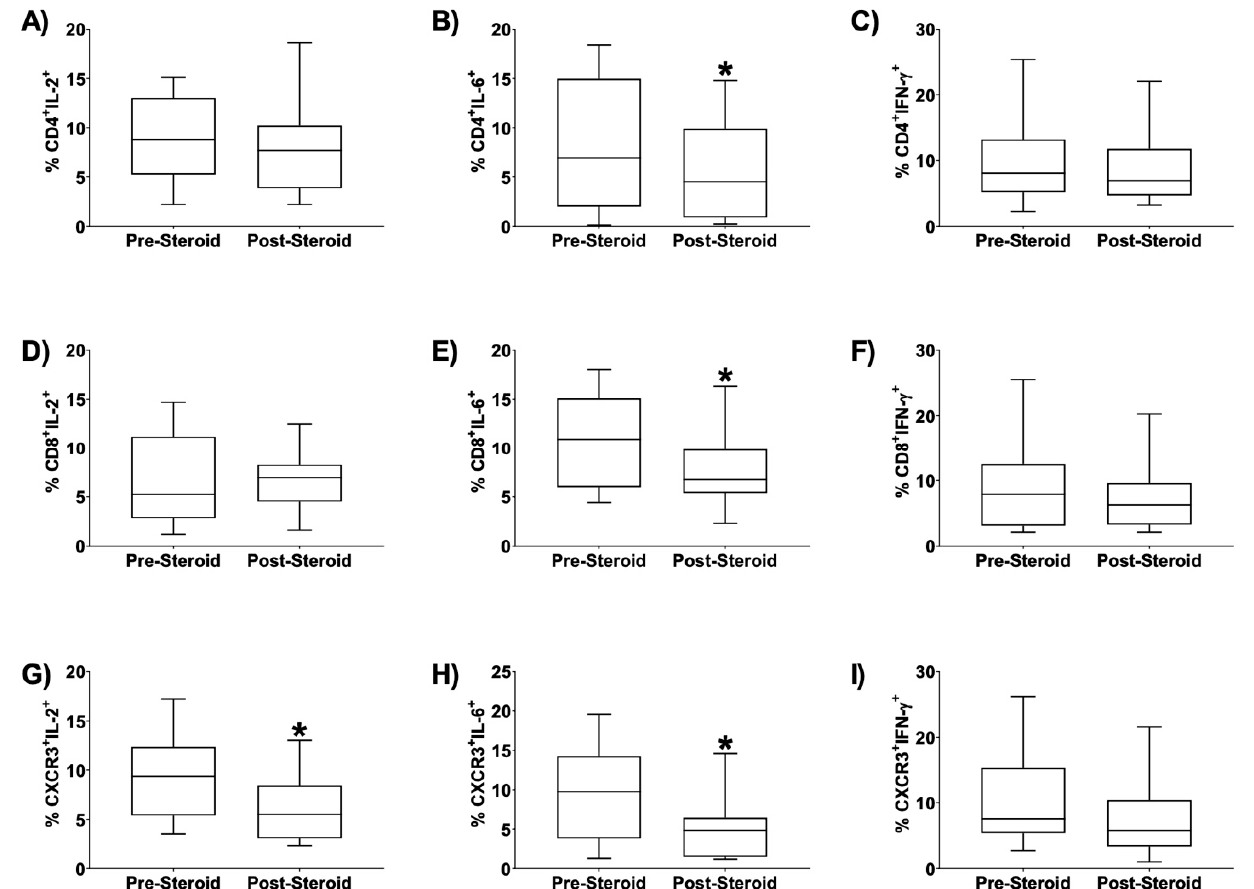
Figure 2. Effect of Dexamethasone on TA T-Cell Subpopulations Expressing IL-2, IL-6, and IFN γ ( A–I ).Several subpopulations of tracheal aspirate (TA) T-cells were significantly altered after dexamethasone initiation. Flow cytometry demonstrated a significant reduction in CD4 + IL-6 + (panel B, * p = 0.01), CD8 + IL-6 + (E, * p = 0.01), CXCR3 + IL-2 + (G, * p = 0.04), and CXCR3 + IL-6 + (H, * p = 0.006) live cells in TA of mechanically ventilated preterm infants following dexamethasone initiation. Infants had TA obtained up to 72 h prior to initiation of the 10-day dexamethasone course and then a subsequent TA collection 1 to 3 calendar days after dexamethasone was initiated. n = 14. Statistical comparisons generating reported p values were by Wilcoxon signed-rank test.